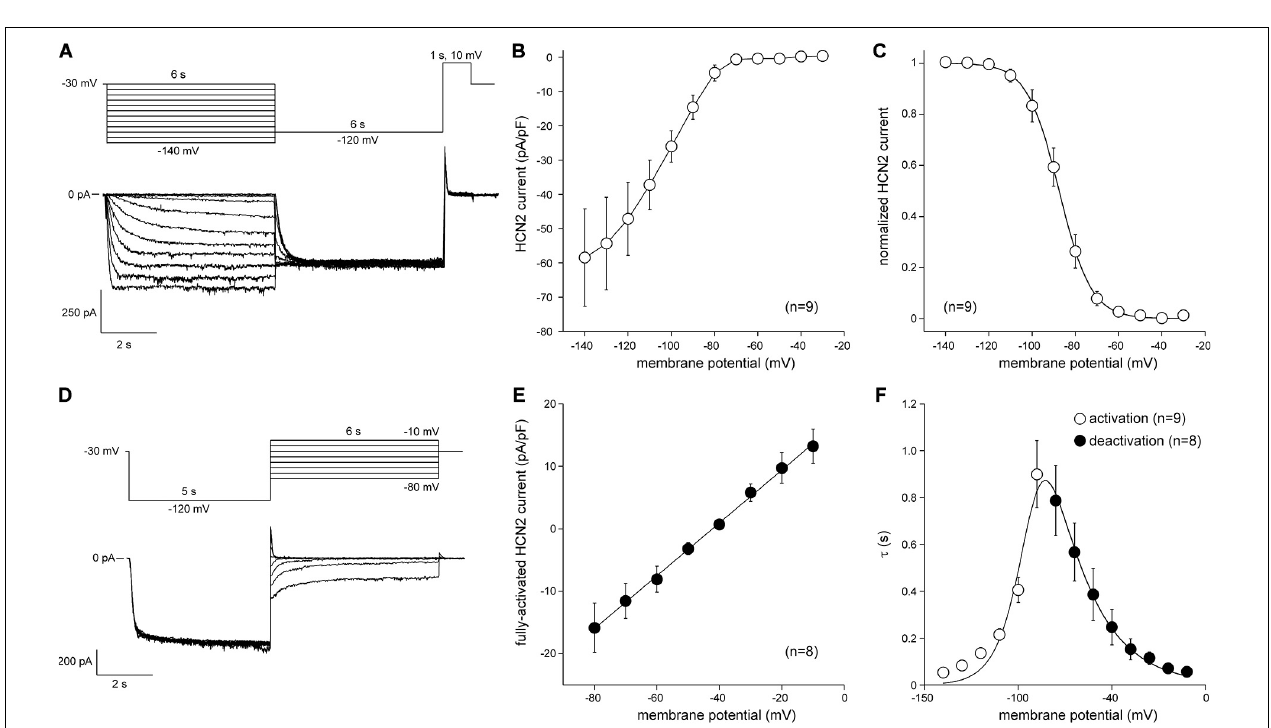
FIGURE 5 | Hcn2 current measured at 36 ◦ C in single LV-transduced CPCs. (A) Typical Hcn2 current traces (bottom panel) activated with a double pulse voltage clamp protocol (top panel) to determine current density and activation properties. (B) Average current-voltage (I–V) relationship of the Hcn2 current. (C) Voltage dependence of Hcn2 current activation. Solid line is the Boltzmann fit to the experimental data. (D) Typical Hcn2 current traces (bottom panel) activated with a double pulse voltage clamp protocol (top panel) to determine the reversal potentials and deactivation properties. (E) I–V relationship of the fully activated Hcn2 current. Solid line is the linear fit to the experimental data. (F) Time constants of (de)activation. Solid line is the best fit curve to the equation τ = 1/[A1 × exp(–V/B1) + A2 × exp(V/B2)], where τ is the activation or deactivation time constant (s), and A1, A2, B1, and B2 are calculated fitting parameters, which amount to 3.2164 · 10 - 8 s - 1 , 9.2311 s - 1 , 0.041248 mV, and 21.724 mV, respectively (Qu et al., 2004).